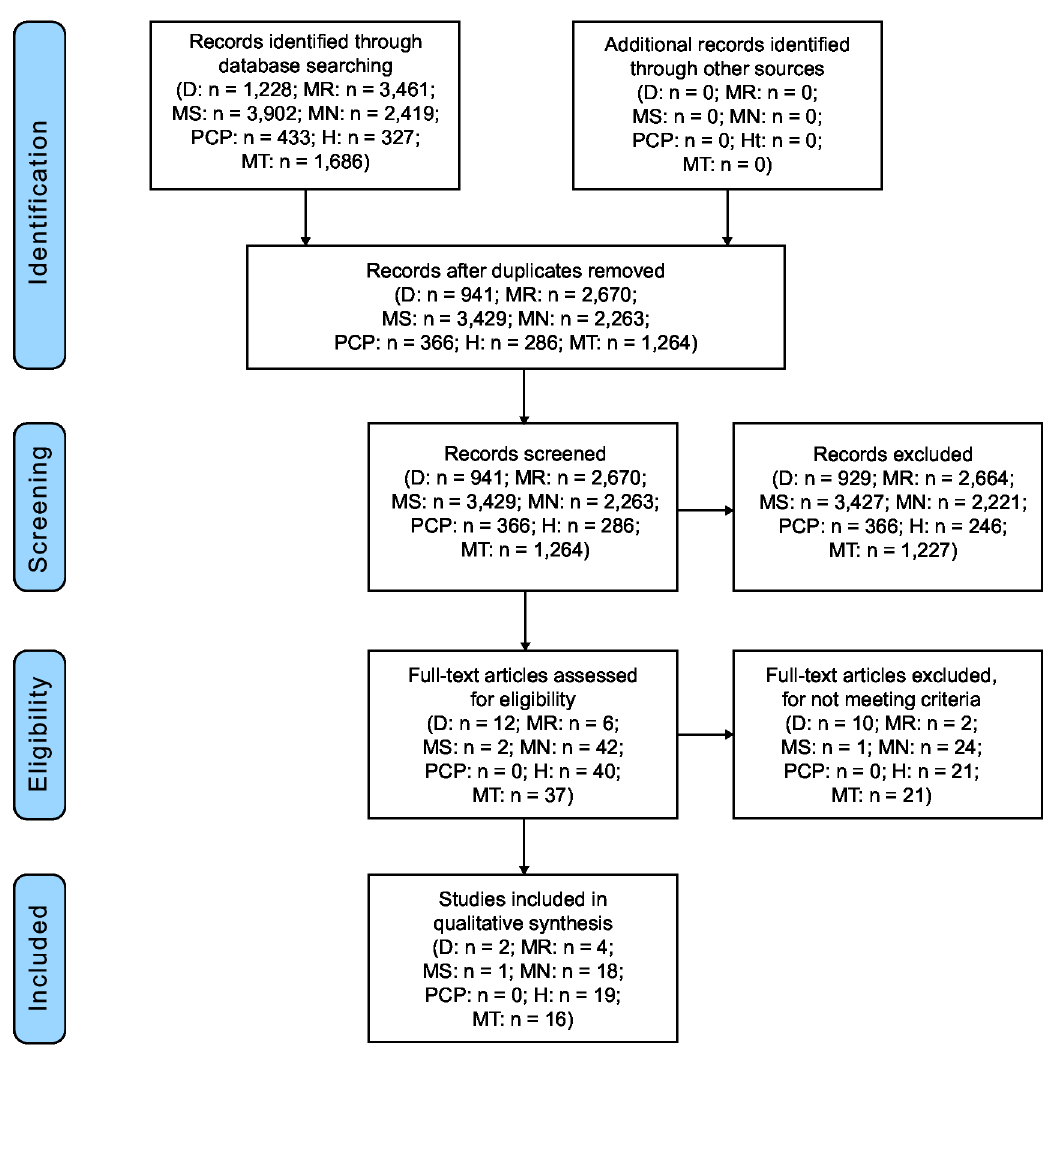
Fig 1. PRISMA flow diagram for systematic reviews of influenza and dengue (D), malaria (MR), measles (MS), meningococcus (MN), Pneumocystis jirovecii pneumonia (PCP), hemoglobinopathies (H), and malnutrition (MT).